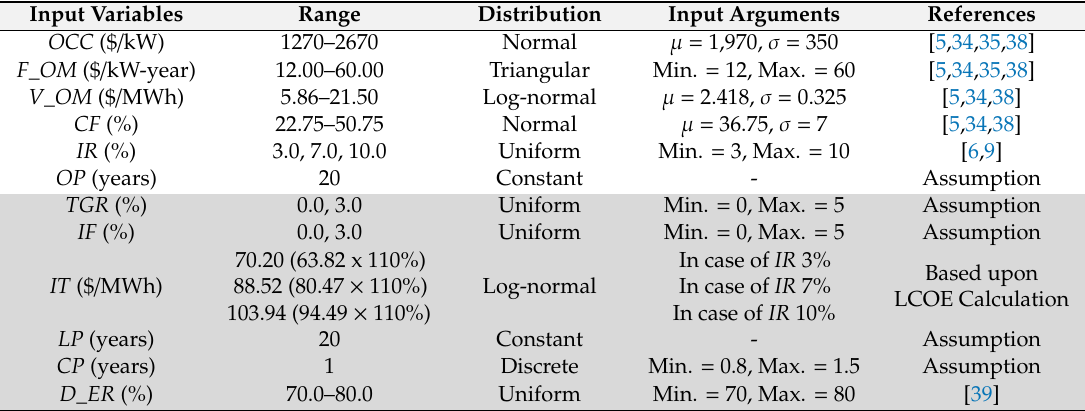
Table 2. Wind Input